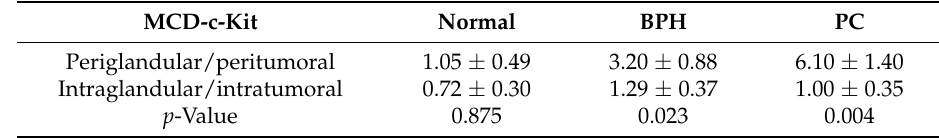
Table 2. Mast cell density (MCD) in periglandular/peritumoral areas versus intraglandular/intratumoral areas based on tryptase immunoexpression. p -Value is significant in all the three groups: normal, benign prostate hyperplasia (BPH) and prostate carcinoma (PC).